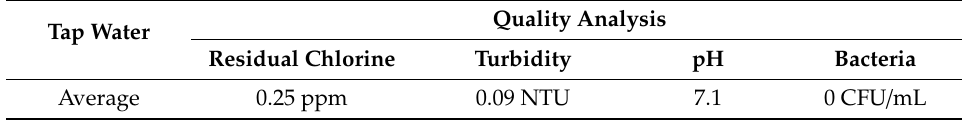
Table 2. Quality analysis of tap water in Andong city, South